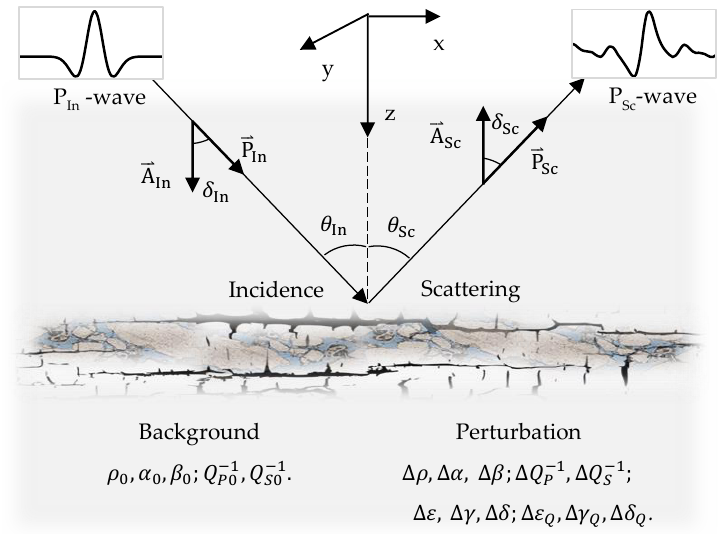
Figure 1. Schematic of seismic wave propagate in an attenuation anisotropy medium based on the perturbation theory. It is characterized by three elastic parameters P-wave velocity α , S-wave velocity β and density ρ ; two viscoelastic parameters P-wave quality factor Q P and S-wave quality factor Q S ; three anisotropic Thomsen parameters ε , γ , δ and corresponding attenuation Thomsen parameters ε Q , γ Q , δ Q . Note that the subscript ‘0 (cid:48) stands for the properties of background (reference medium) and the mark ‘ ∆ ’ stands for the properties of small perturbation.